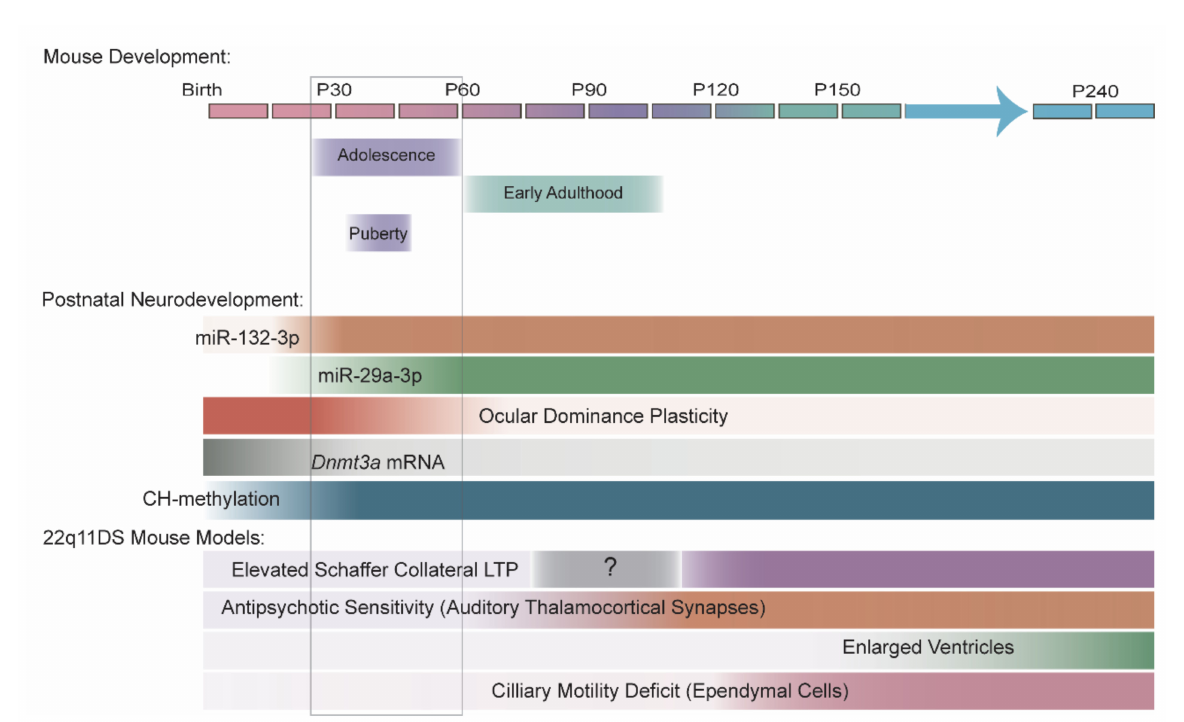
Figure 4. Overview of mouse postnatal neurodevelopment and the timing of SCZ-associated phenotypes in 22q11DS mouse models. Mouse adolescence begins with weaning at ~P22 and ends with the onset of full sexual maturity at ~P60. Increases in miR-29a-3p and miR-132-3p before and during adolescence inhibit ocular dominance plasticity and limit DNMT3A-driven CH-methylation in the visual cortex, providing an example of how temporal regulation of miRNA levels drives late brain maturation in mouse models. Several miRNA-dependent phenotypes also display an age-dependent onset in mouse models of 22q11DS that mimics the developmentally delayed onset of SCZ in patients. In the hippocampus, elevated LTP at Schaffer collateral (CA3–CA1) synapses is absent at P60 but apparent by P120. The exact timing of this phenotype’s onset is unclear, however. Deficits in auditory thalamocortical synapses gradually appear between P60 and P120. Ventricular enlargement is developmentally delayed; however, the ciliary motility deficit in ependymal cells that underlies this phenotype is observed by